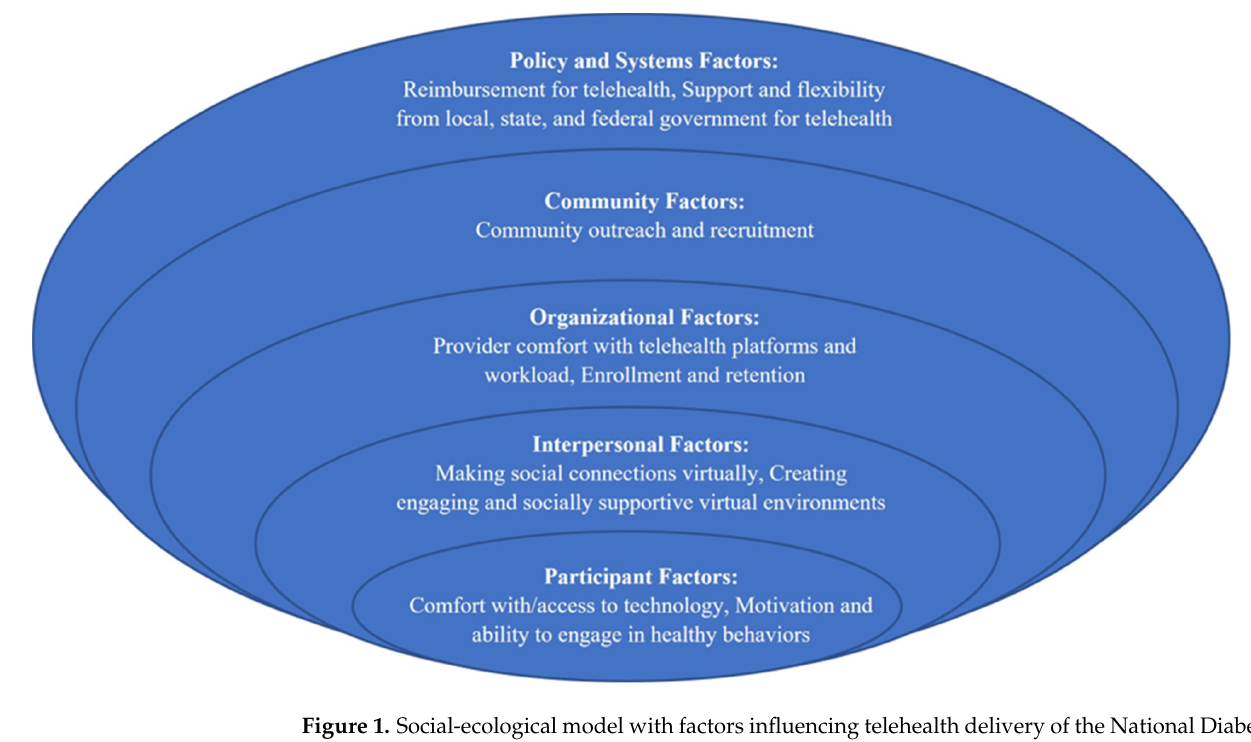
Figure 1. Social-ecological model with factors influencing telehealth delivery of the National Diabetes Prevention Program and Diabetes Self-Management Education and Support program during the COVID-19 pandemic. Table 2. Themes and representative quotes related to telehealth delivery of the National Diabetes Prevention Program and Diabetes Self ‐ Management Education and Support program during the COVID ‐ 19 pandemic by level of the social ‐ ecological model.